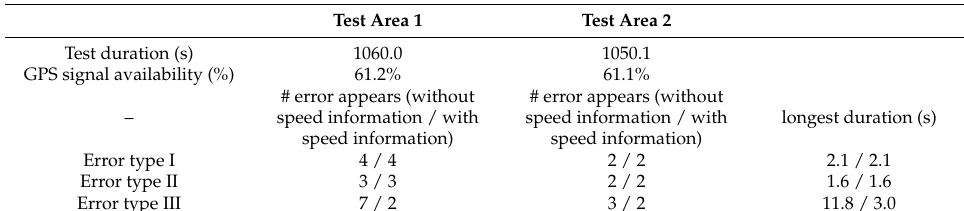
Table 3. Map-matching algorithm results.